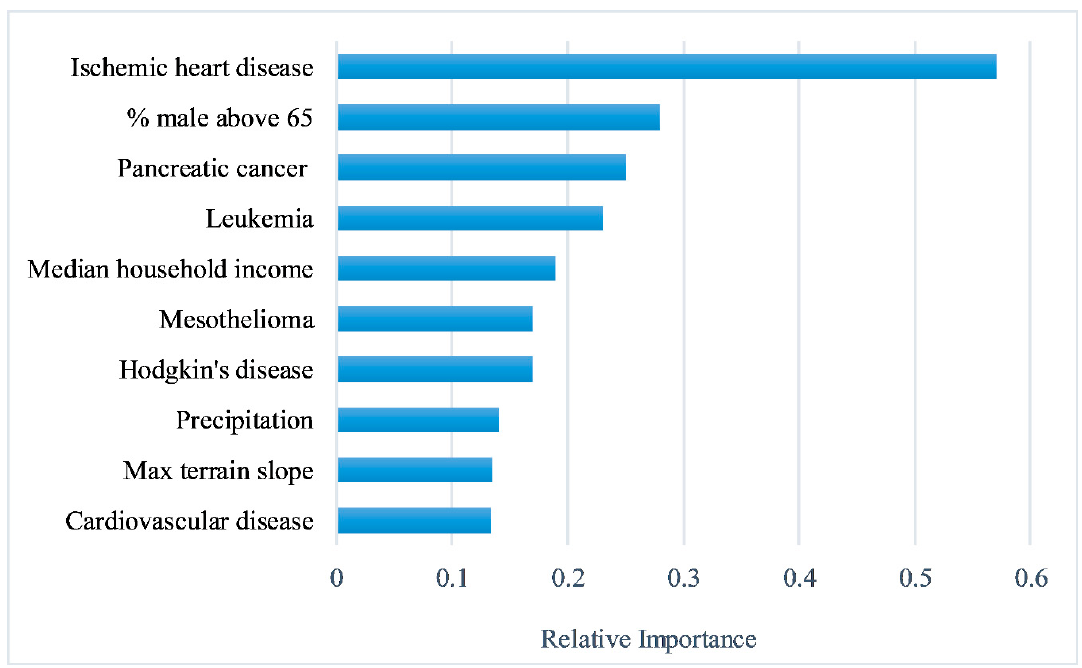
Figure 4. The relative importance of the top 10 variables to the COVID-19 incidence rate, using sensitivity analysis by one hidden layer MLP, continental United States.